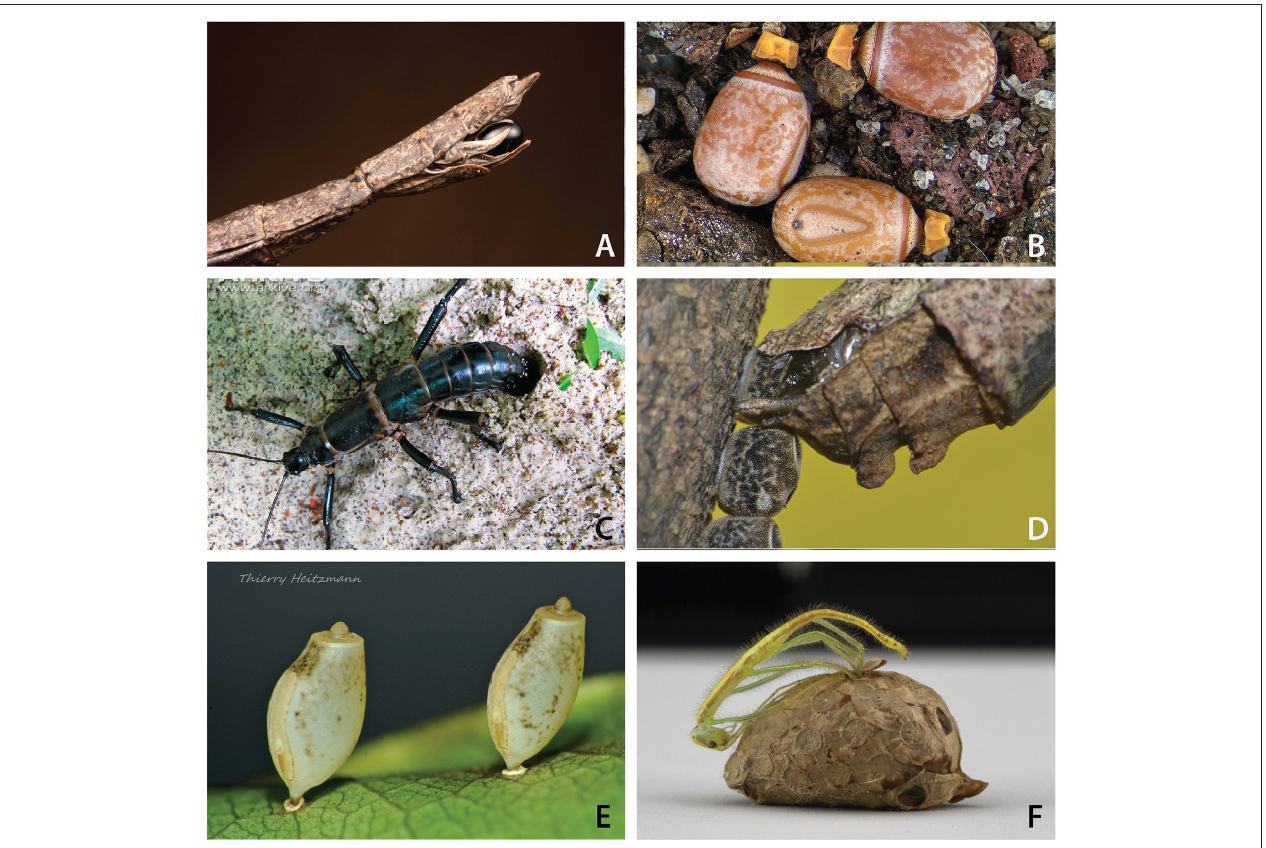
FIGURE 2 | Phasmid oviposition techniques and eggs. (A) Ovipositor and mature egg of Diapheromera femorata . Photo © Alex Wild, used by permission. (B) Capitulate eggs of Eurycnema goliah . Photo by Piotr Naskrecki, used by permission. (C) Dryococelus australis depositing eggs in soil. Photo by Rohan Cleave, Zoos Victoria, Australia, used by permission. (D) Neoclides sp. gluing eggs to branch. Photo by Albert Kang, used by permission. (E) Asceles eggs skewered into leaf. Photo by Thierry Heitzmann, used by permission. (F) Korinninae nymph emerging from ootheca. Photo by Bruno Kneubühler, used by permission.